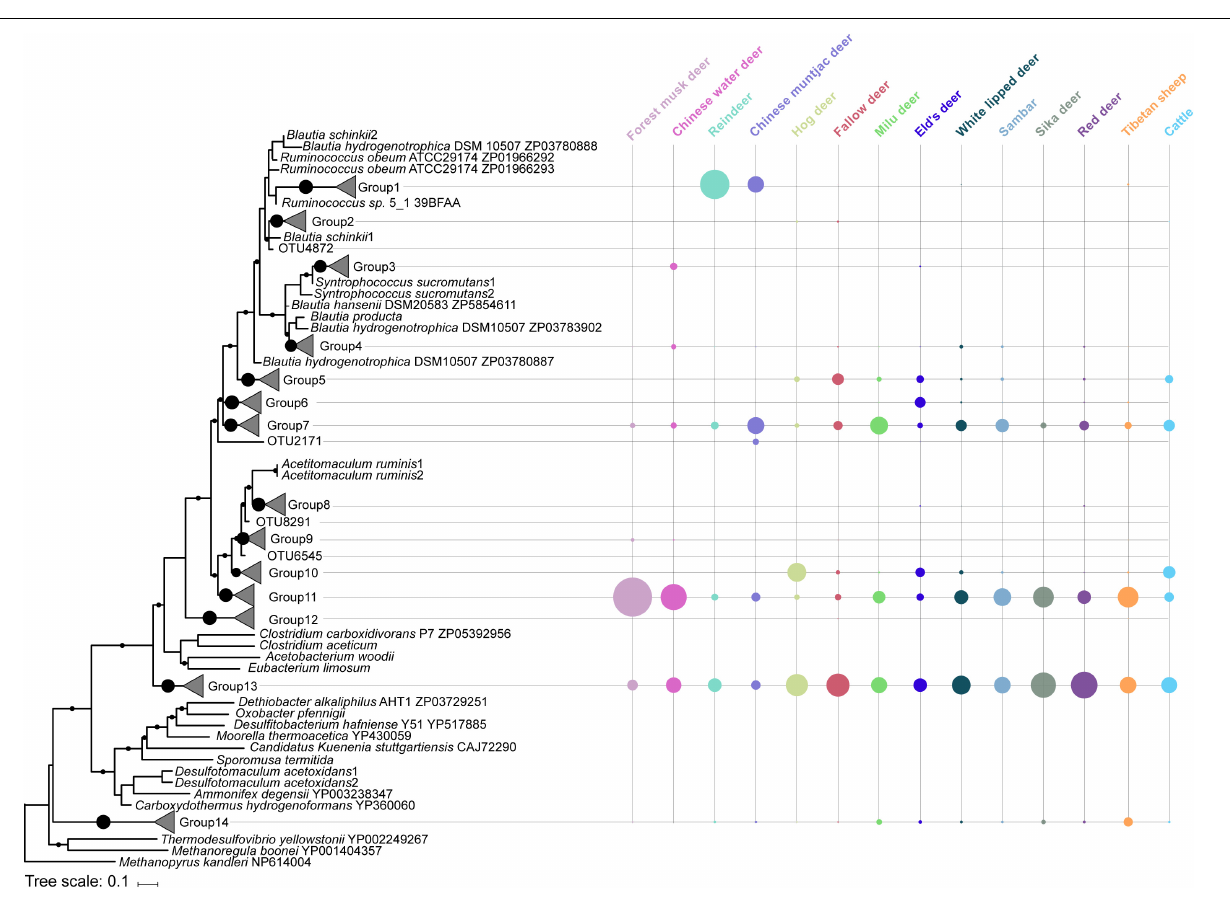
FIGURE 3 | Acetogen composition based on the phylogenetic analysis of acetyl-CoA synthase amino acid sequences in the rumen of 14 ruminant species. Bootstrap values greater than 75% are shown at the nodes. The scale bar represents a sequence divergence of 10%. The node size on the right side represents the relative abundance of each group or operational taxonomic unit